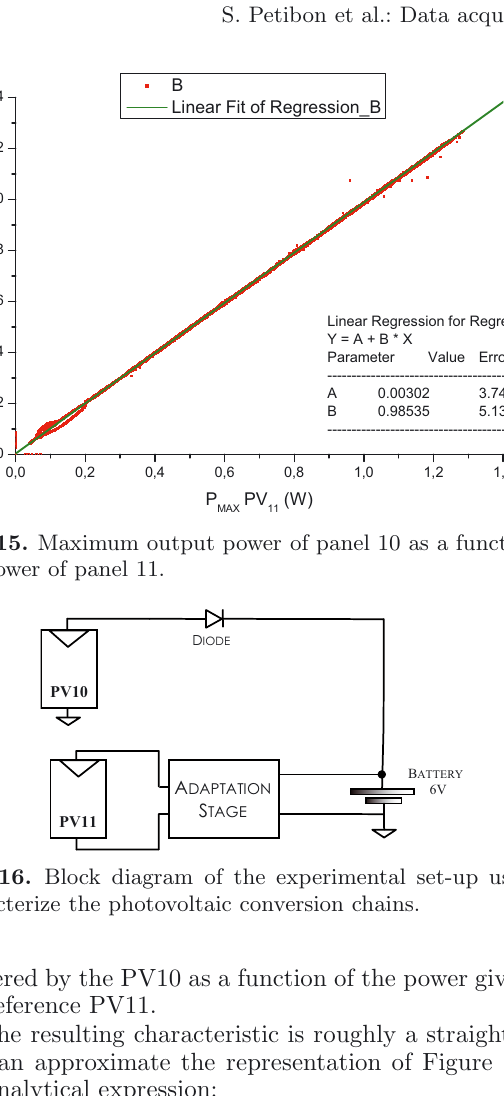
Fig. 18. Powers and efficiencies of the adaptation stage for one day